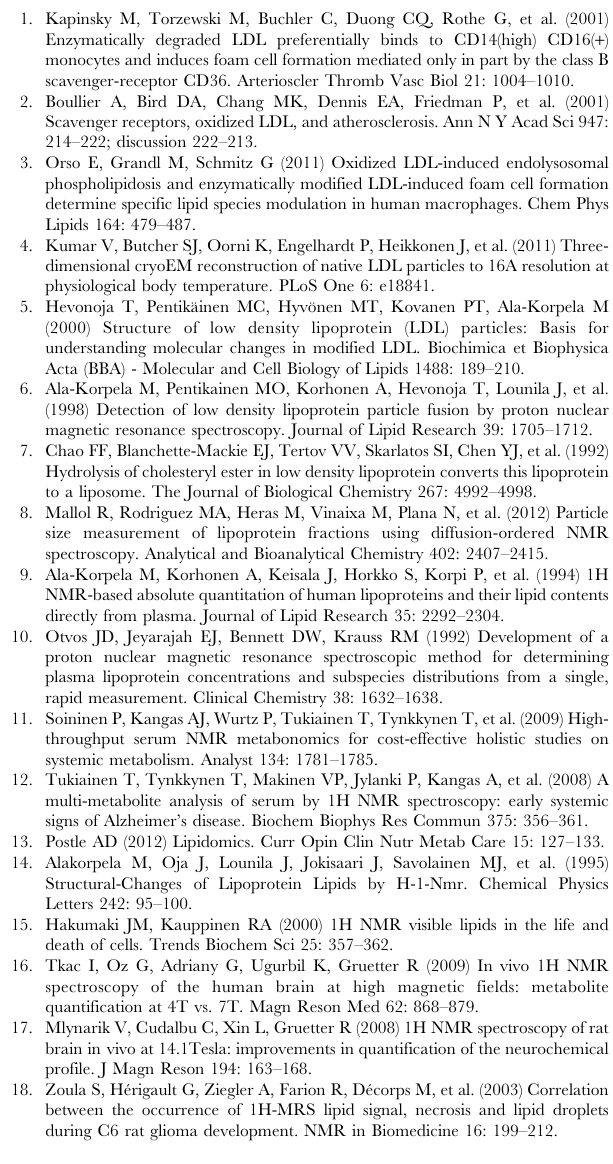
Table S2 Resonance assignment used for deconvolution of NMR spectra of macrophage suspensions. Lineshape abbrevia- tions: singlet (s), doublet (d), multiplet (m), broad peak treated as singlet (b), multiplet treated as broad singlet